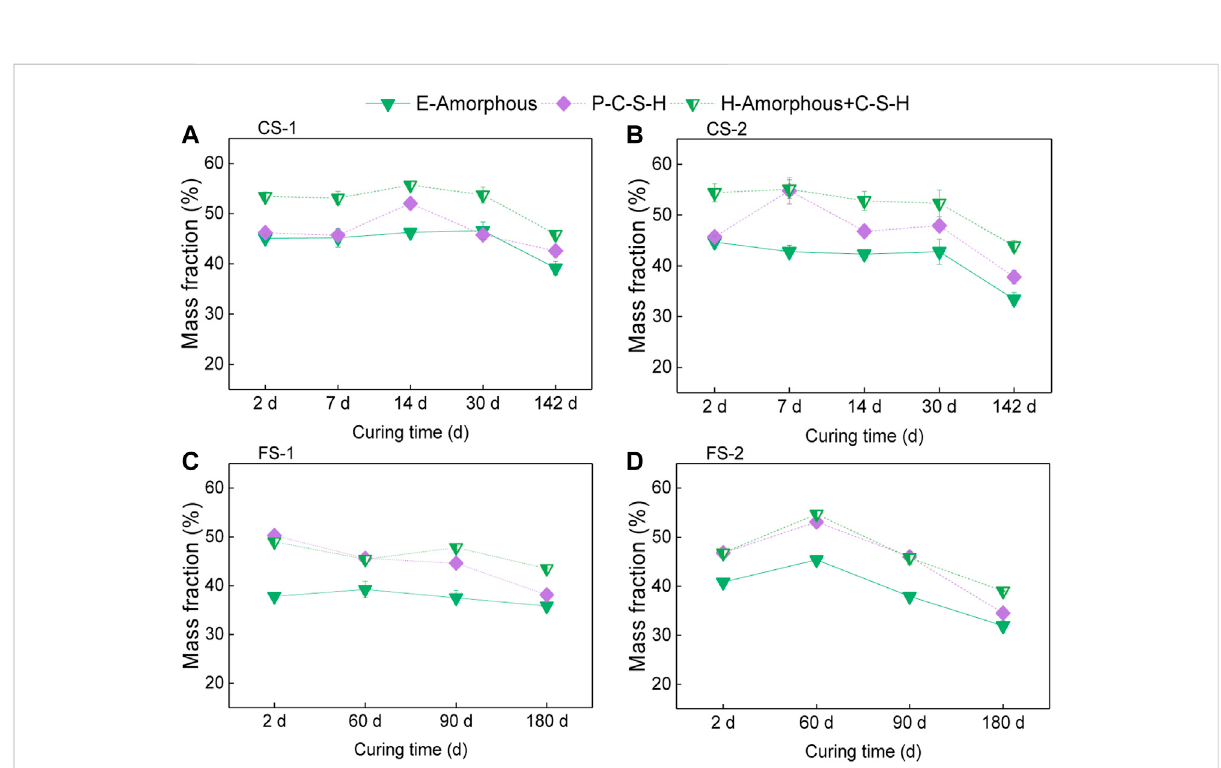
FIGURE 10 Comparisonoftheamorphousphasecontentobtainedbydifferentmethods.(E:theexternalstandardmethod;P:thePONKCSmethods;H:the hybrid method). (A) slurry CS-1 (B) slurry CS-2 (C) slurry FS-1 (D) slurry